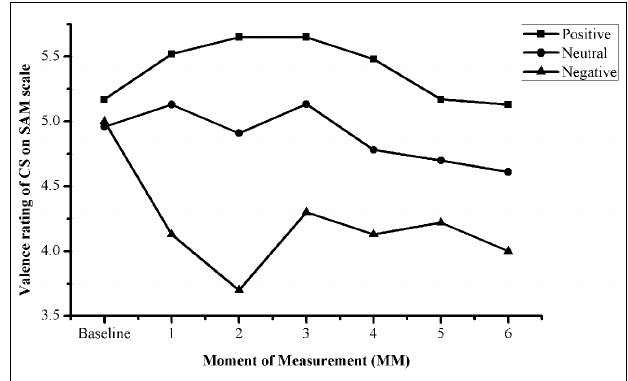
FIGURE 1 | Mean of ratings on the nine-point SAMv scale per moment of measurement for CS sounds that were paired with positive, negative, or neutral US words at different moments of measurement (MM). MM 1 and 2 are after 10 and 20 CS–US parings, respectively. MM 3, 4, 5, and 6 are after 10, 20, 30, and 40 extinction trials,